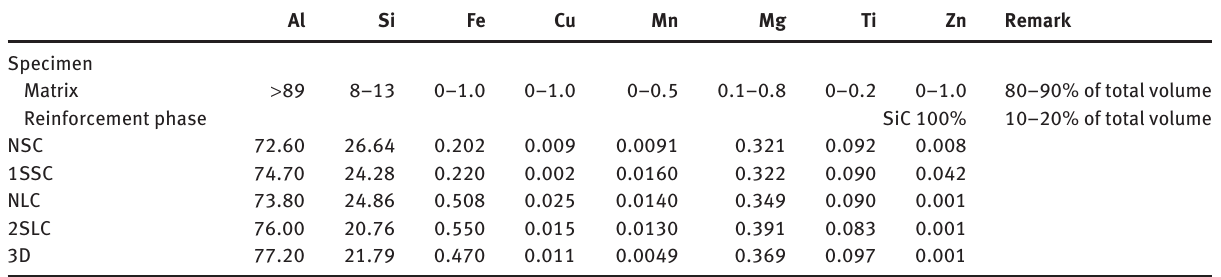
Table 2 Nominal and actual chemical compositions (wt%) of various Al foam